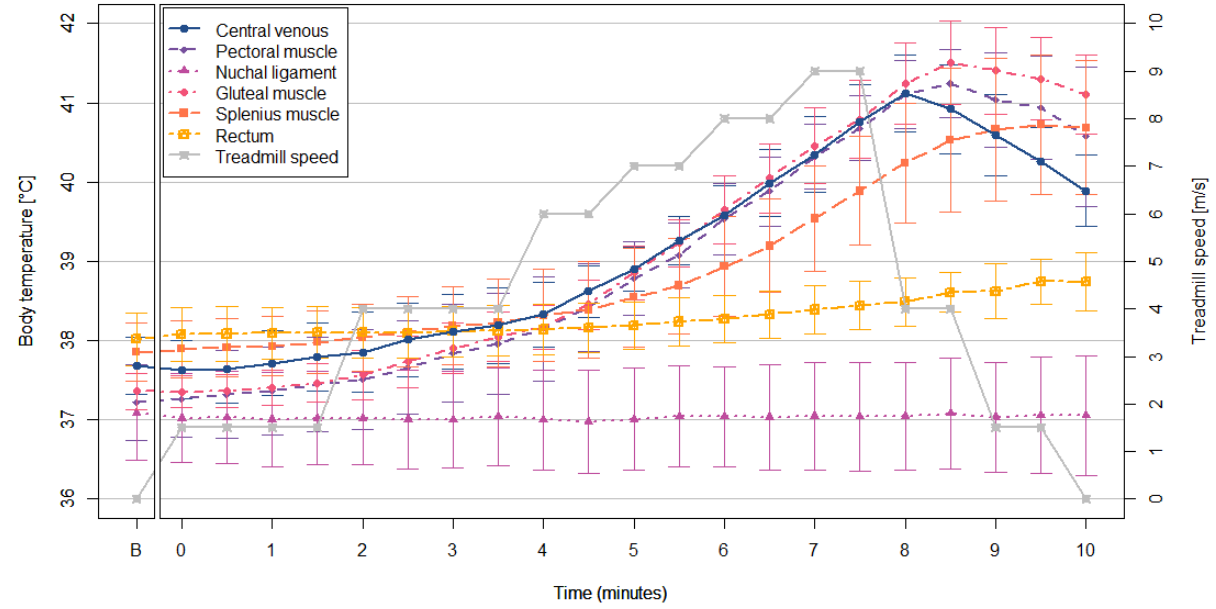
Figure 3. The PTSM temperatures and treadmill speed during the treadmill exercise. Abbreviations: B = before treadmill exercise.